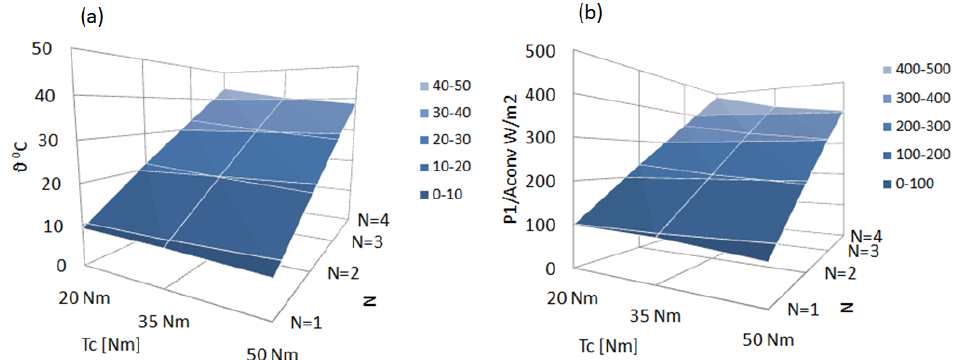
Figure 15. Three-dimensional charts: ( a ) maximum temperature vs. clutching torque and number of discs; ( b ) ratio ∆ P Cu / A conv ratio vs. clutching torque and the number of